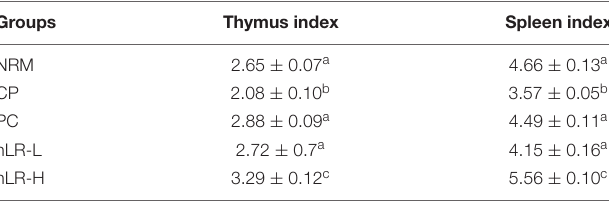
TABLE 2 | Effects of hLR on the immune organ (thymus and spleen) index in mice. Groups Thymus index Spleen